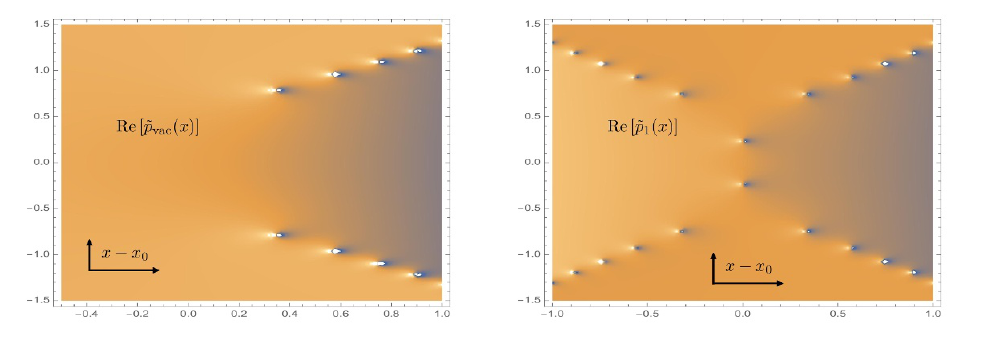
0 : 405 0 : 035 i . 0 (cid:25) (cid:6)